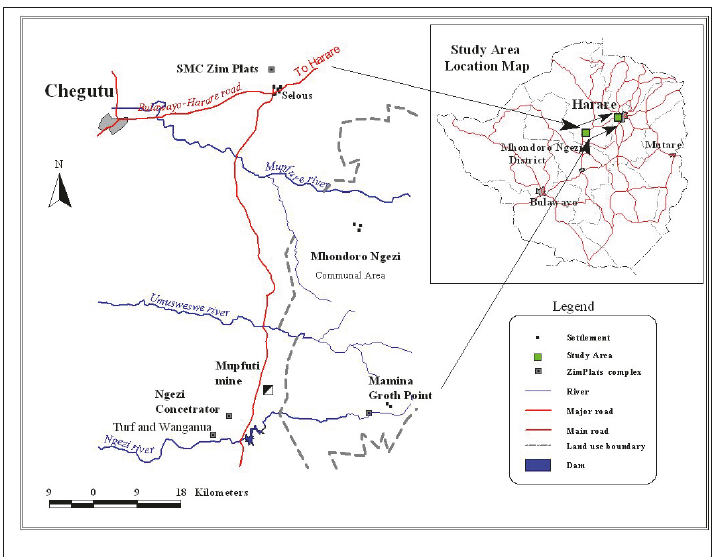
Figure 1: Location of the Study Area (Source: Nyamande,